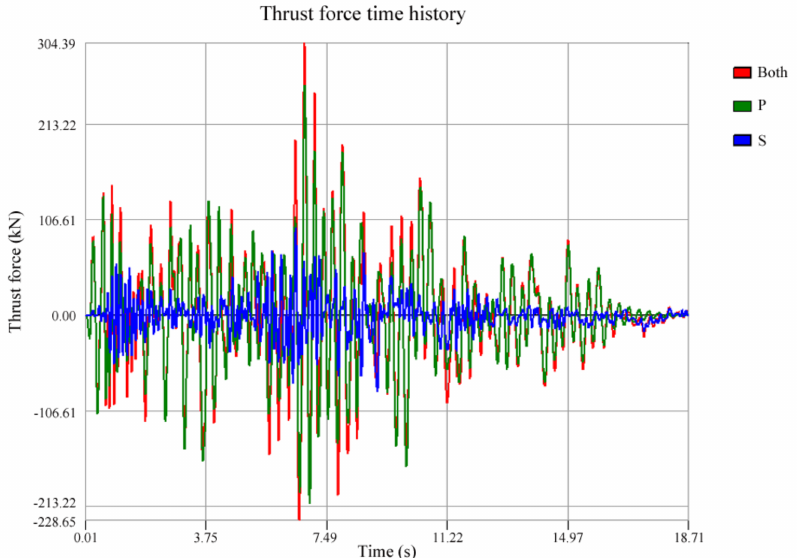
Figure 8. Thrust force time histories of the studied beam element subjected to P wave, S wave, and both